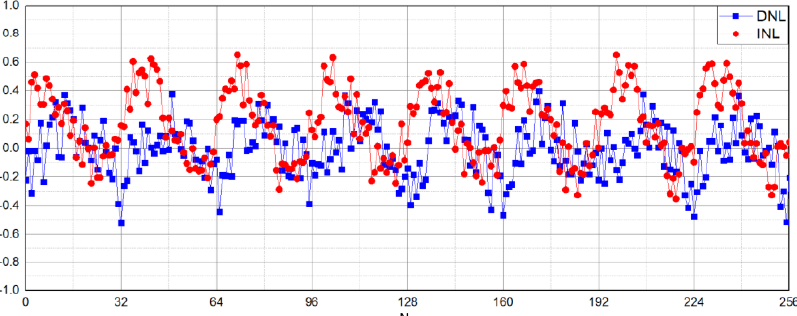
Figure 21. DNL and INL of